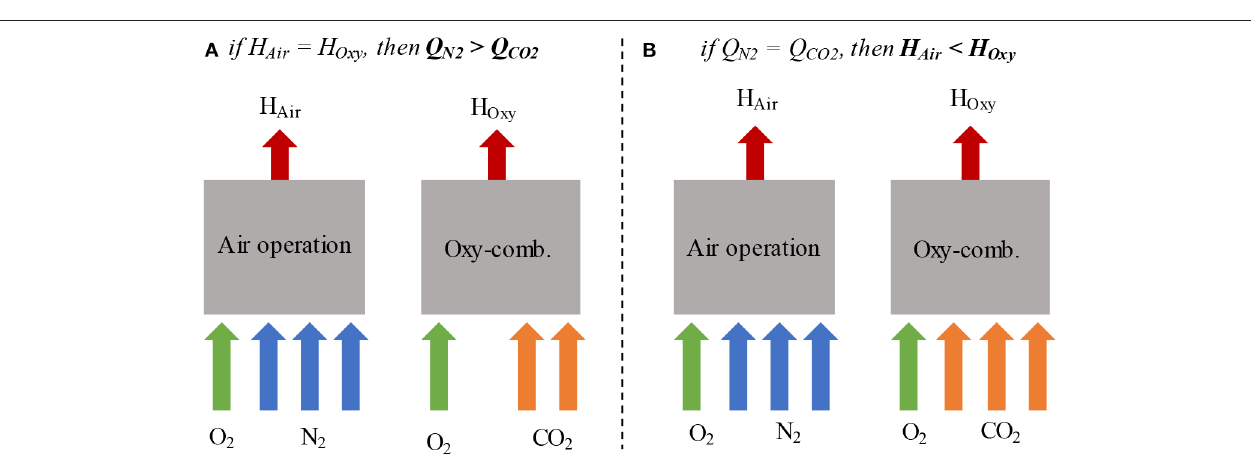
FIGURE 7 | Oxy-combustion capture in FCC units adapted from Miracca and Butler (2015) with permission from BP Group Technology.